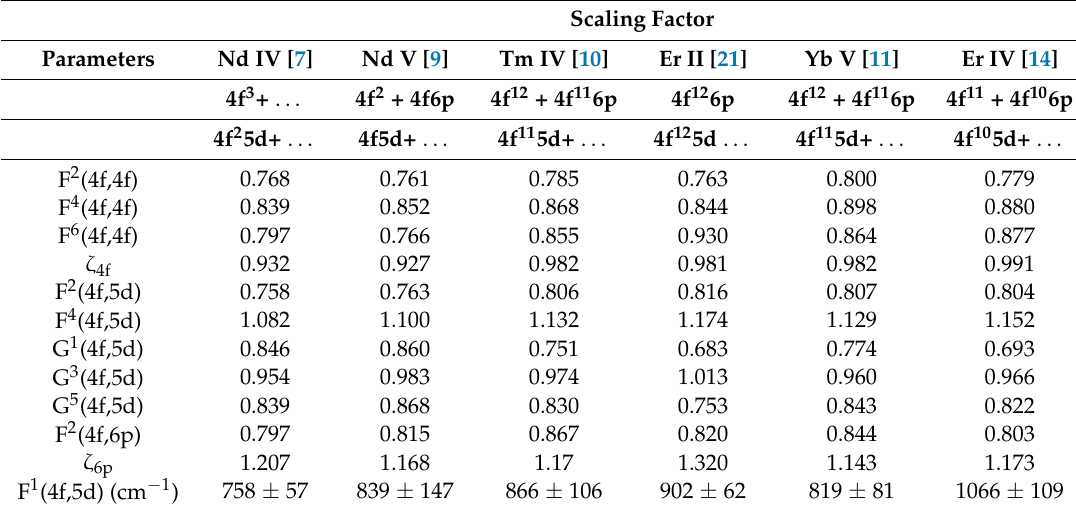
Table 6. Consistency of scaling factor (SF) values of energy parameters SF = P fit /P HFR